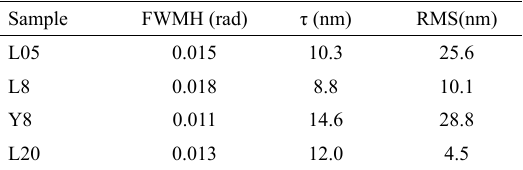
Figure 1. Diffractograms of the superlattices with 0.5nm (L05), 8nm (L8 and Y8) and 20nm (L20) PBCO layers, and the substrate LaAlO Table 2: Full width half maximum (FWMH) of Y(007) peak, estimated average crystallite size of YBCO and roughness (RMS) obtained for each